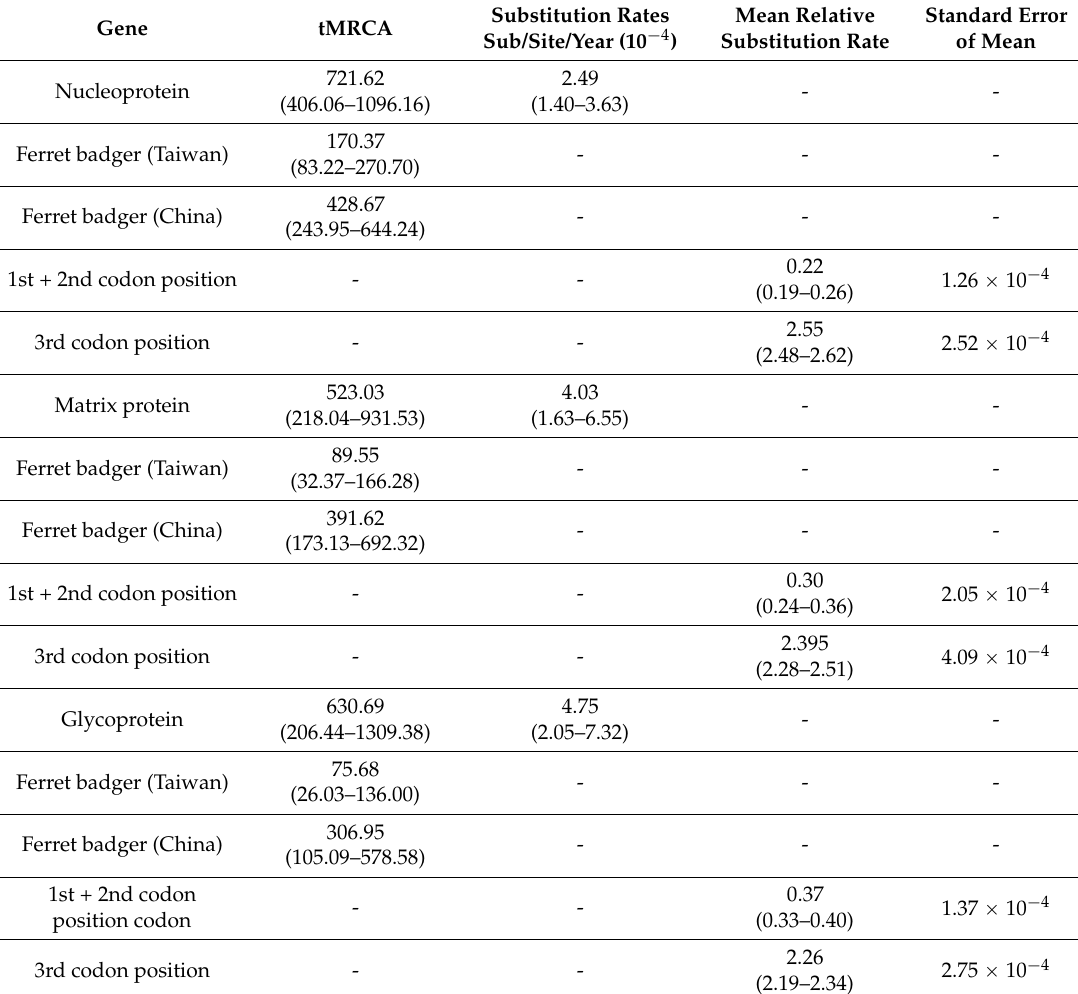
Table 1. Mean relative evolutionary rates for codon positions and times of most recent common ancestor (tMRCA) in nucleoprotein, matrix protein, and glycoprotein